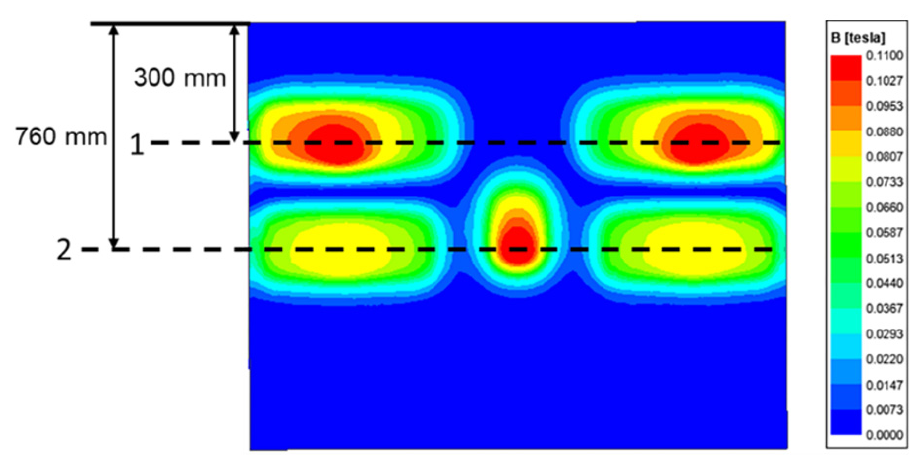
Figure 7. Location diagram of regional characteristic line of magnetic flux intensity.